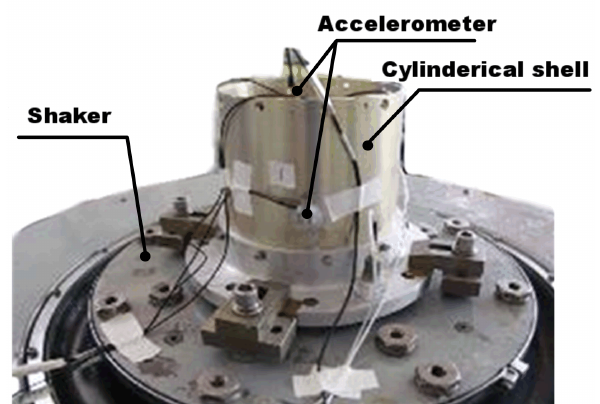
Figure 6. Image of the sine-sweep test system (accelerometer